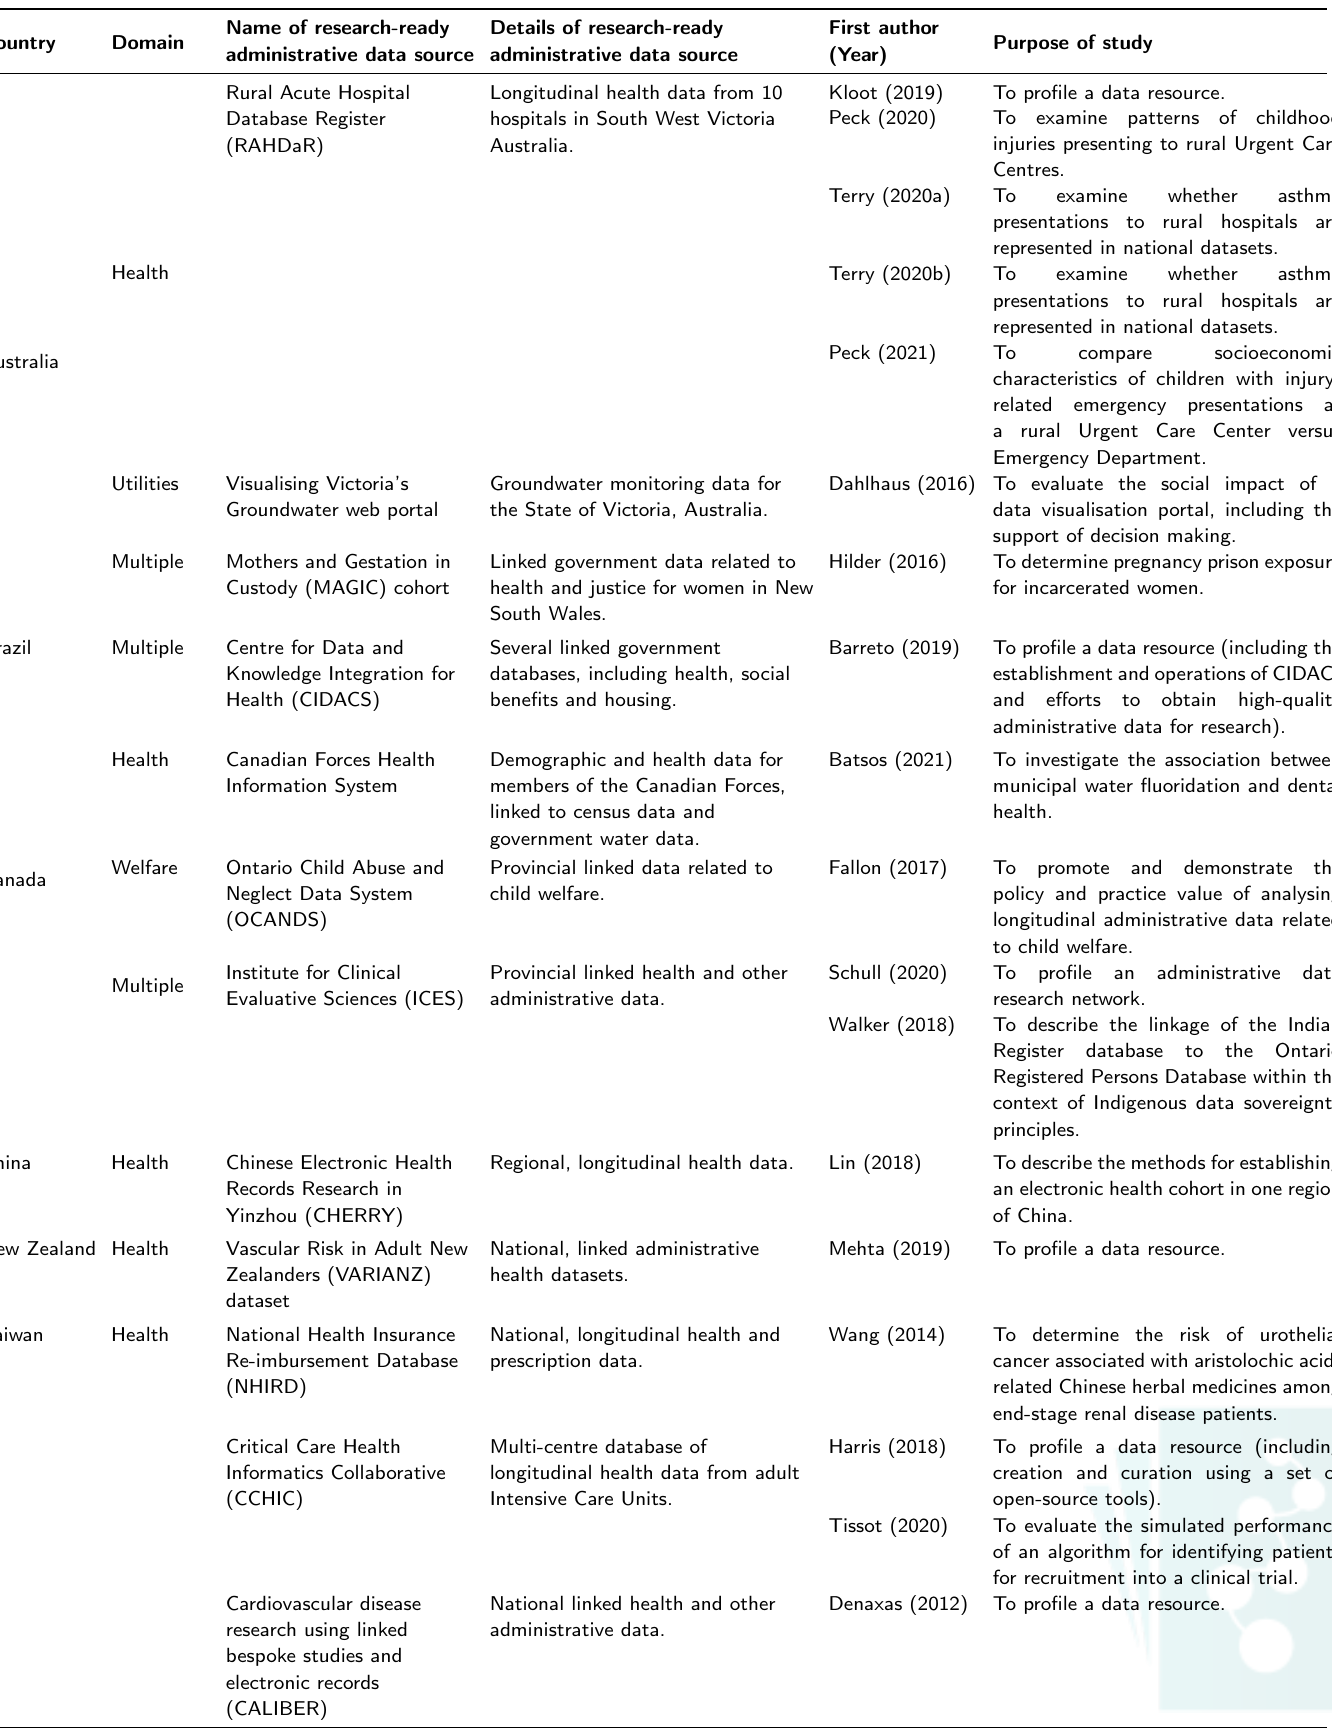
Table 1: Summary of included publications, by country and domain of administrative